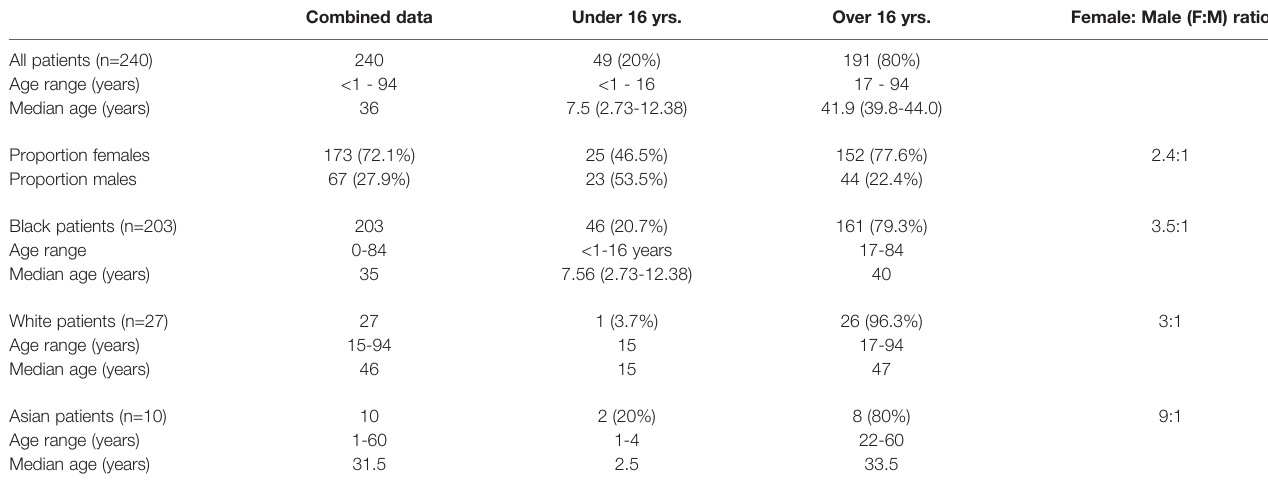
TABLE 1 | Demographic pro fi le of patients. Combined data Under 16